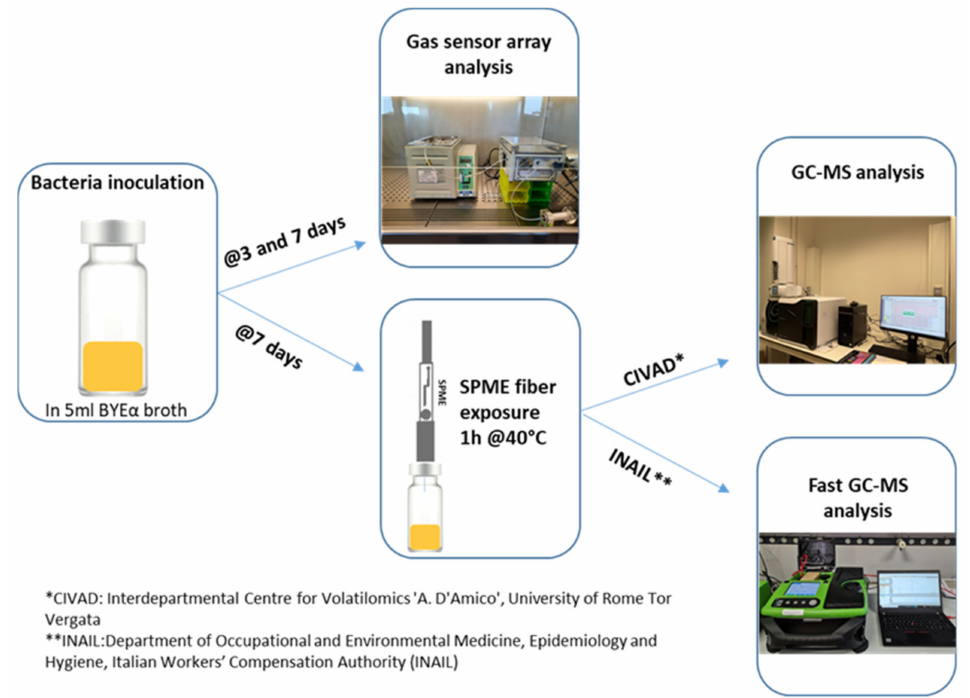
Figure 1. Schematic representation of experimental